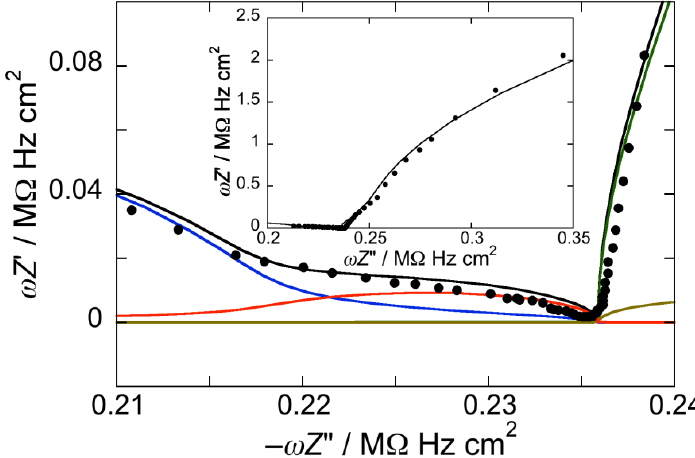
Figure 3. Plot of ω Z ′ against −ω Z ″ for a Hg-supported DOPC/GM1 (80:20) mol% monolayer in aqueous 0.1 M KCl at − 0.550 V. Solid circles are experimental points and the black curve is the best fit to these points by a series of four RC meshes. The contributions to ω Z ′ against −ω Z ″ are represented in blue for the hydrocarbon tails, in red for the polar heads, in brown for the diffuse layer, and in green for the aqueous solution. Capacitances and resistances of the four RC meshes are: R = 3.2 M Ω ·cm 2 , C = 4.6 µF·cm − 2 , R = 5.5 k Ω ·cm 2 , ht ht ph = 54 µF·cm − 2 , R = 0.3 Ω ·cm 2 , C = 70 µF·cm − 2 , R = 3.2 Ω ·cm 2 , C = 25 nF·cm − 2 . The C ph dl dl Ω Ω impedance spectrum in the inset covers a broader frequency range encompassing the contribution from the aqueous solution.